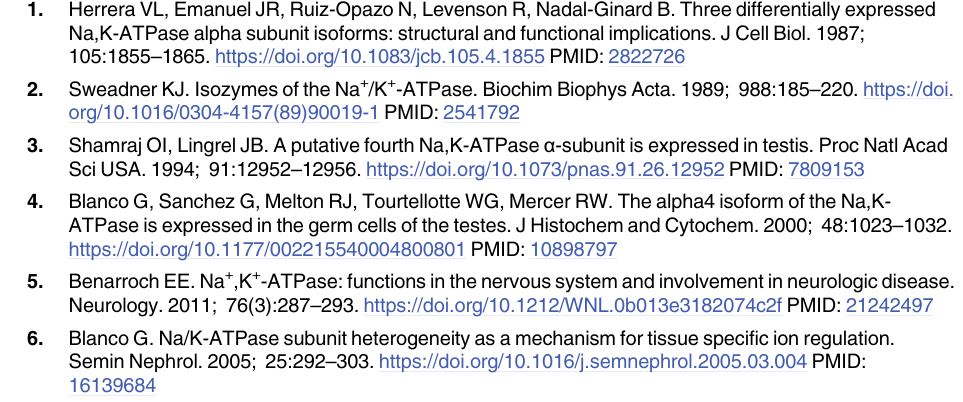
S14 Table. Downregulated gene sets (GeneOntology—Cellular component) in 100nM oua- bain-treated granular neurons at NES >